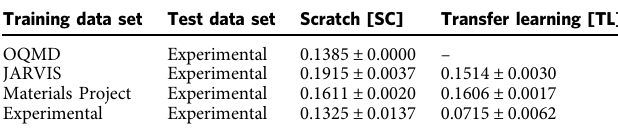
In Table 3, the numerical values reported for the Experimental data sets are incorrect. The correct version of Table 3